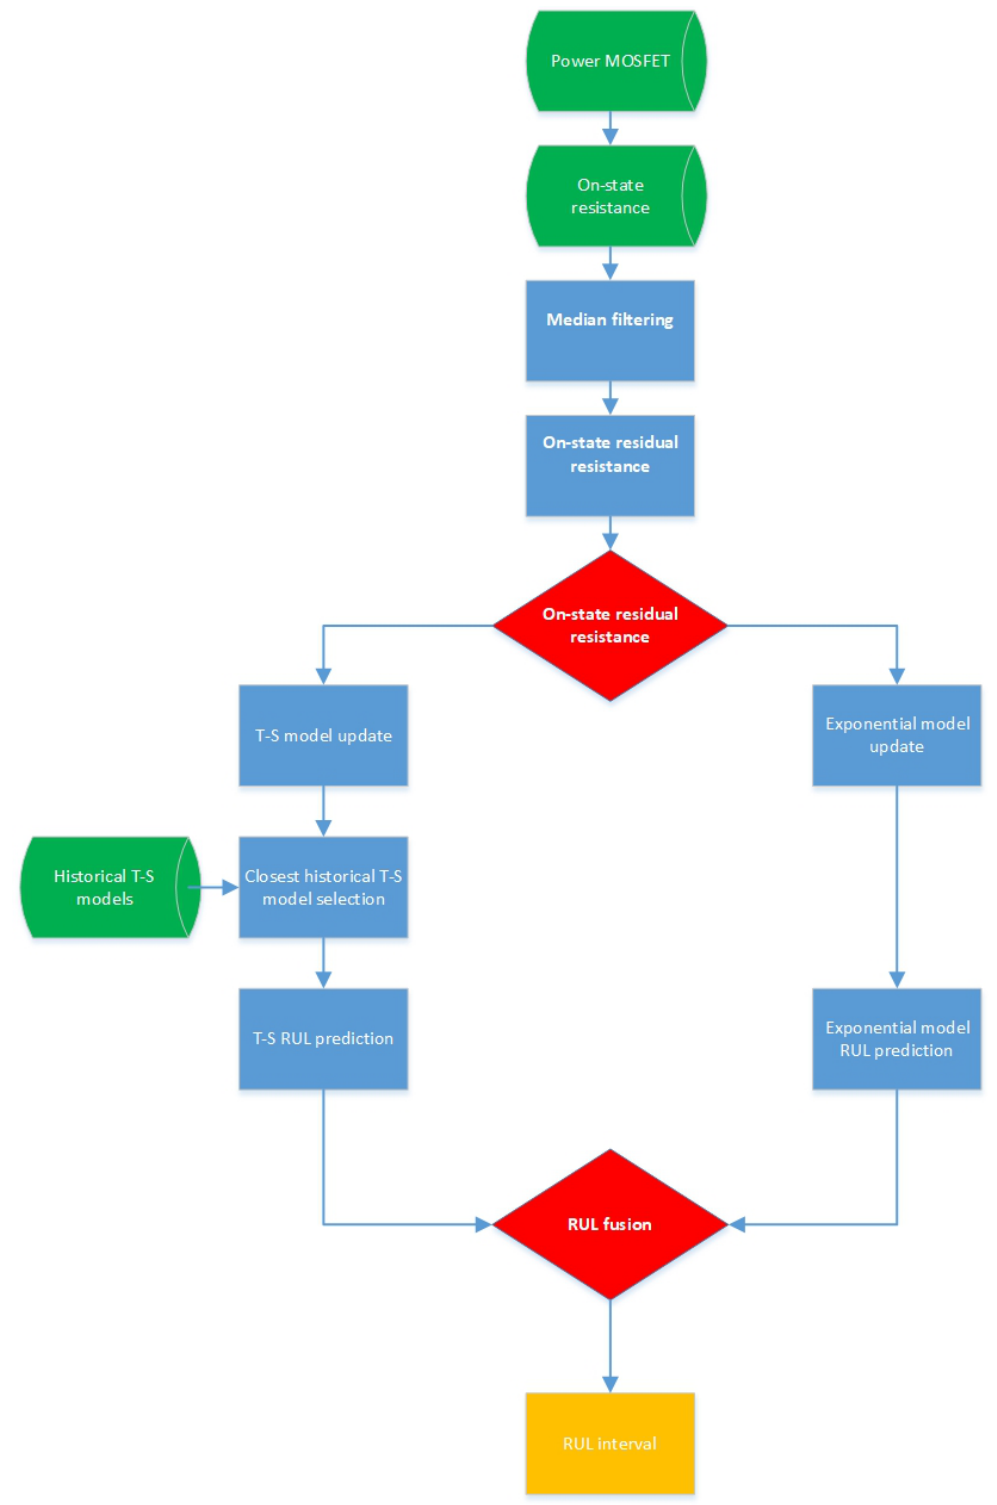
Figure 8. Flowchart of the proposed